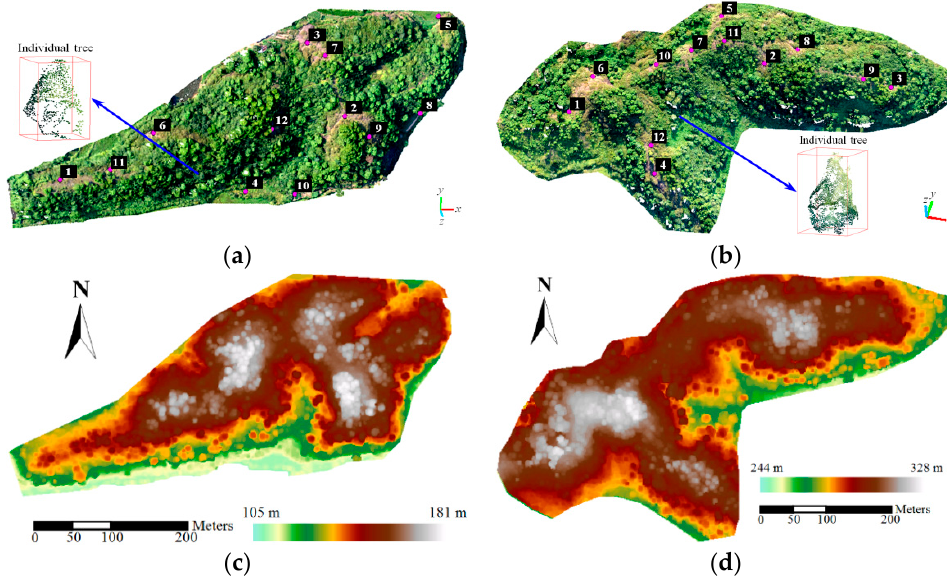
Figure 3. Photogrammetric point clouds and DSMs of the two forest plantations. ( a ) and ( b ) are the photogrammetric point clouds in 3D space with the true color of Plantations 1 and 2, respectively. ( c ) and ( d ) are the DSMs of Plantations 1 and 2, correspondingly. Twelve GCPs are labeled for each of the forest plantations, and the point clouds of individual trees are enlarged to be exhibited in ( a ) and ( b ). DSMs: digital surface models; GCPs: ground control points.